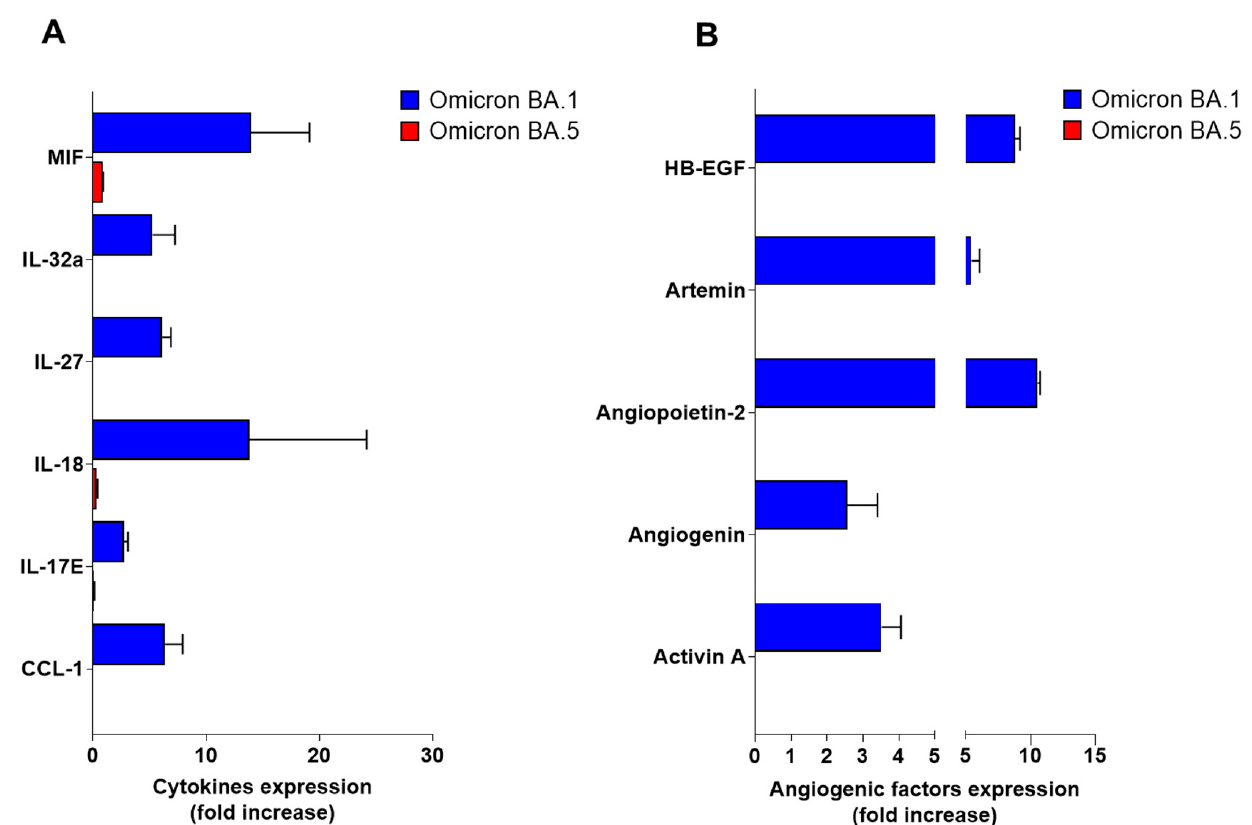
Figure 4. Release of inflammatory cytokines and angiogenic molecules from HL-mECs upon SARS- CoV-2 Omicron BA.1 or BA.5 infection. HL-mECs were mock-infected (Mock) or infected with SARS-CoV-2 belonging to Omicron BA.1 or BA.5 lineages (Omicron BA.1 and Omicron BA.5, respectively) at MOI 1 for 1 h at 37 °C and then washed and cultured until day 3 p.i. Then, supernatants were evaluated for the presence of ( A ) cytokines and ( B ) angiogenic molecules by human proteome arrays. The results are expressed as mean values ± SD of duplicates given as fold increase as compared to Mock cells. Data are representative of one out of two independent experiments with similar results.